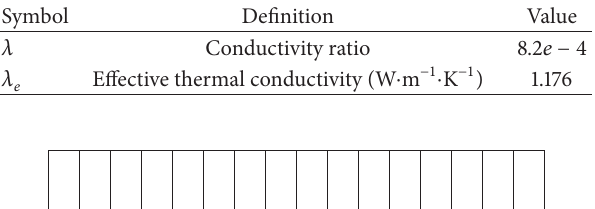
Figure 8: Mesh of the control